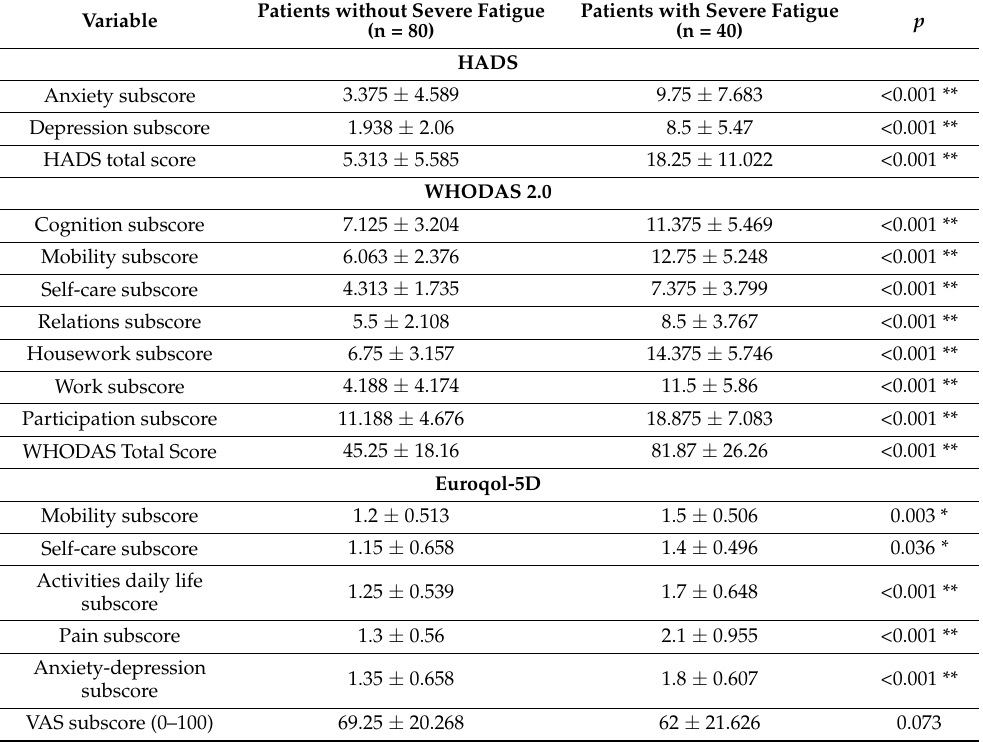
Table 2. Primary variables compared between